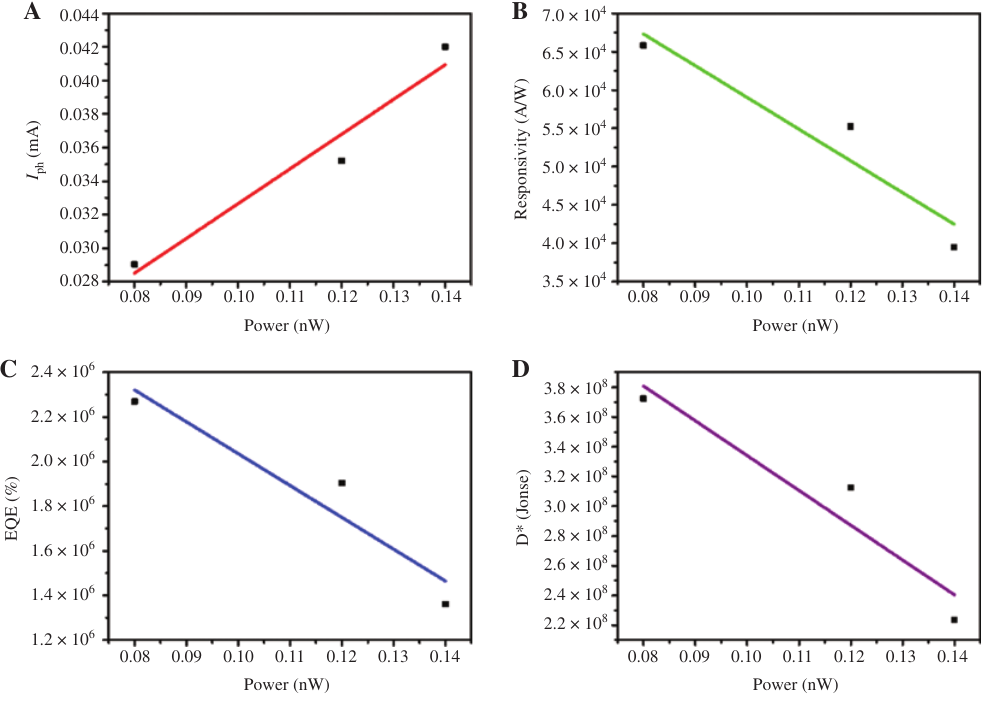
Figure 4: Photoresponse of the Te NS photodetector at 261 nm. (A) Power dependence of photocurrent. (B) Responsivity vs. laser illumination power with an excitation wavelength of 261 nm. (C) EQE vs. laser illumination power with an excitation wavelength of 261 nm, which indicates the high sensitivity of the device. (D) D * vs. laser illumination power with an excitation wavelength of 261